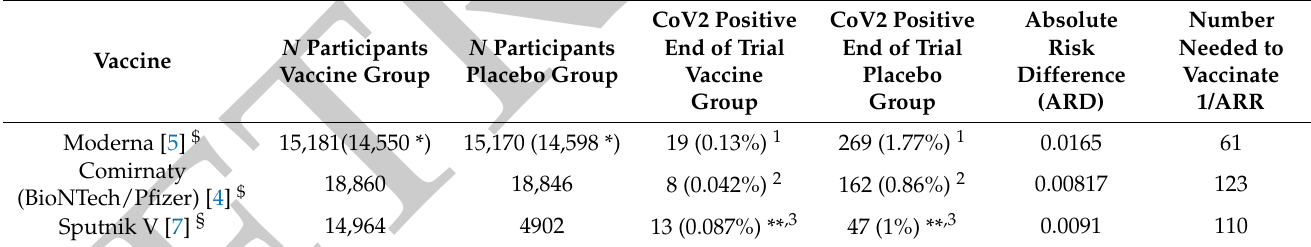
Table 2. Number needed to vaccinate (NNTV) calculated from pivotal phase 3 regulatory trials of the SARS-CoV2 mRNA vaccines of Moderna, BioNTech/Pfizer, and Sputnik (the vector vaccine of Astra-Zeneca is not contained here, as the study [9] was active-controlled and not